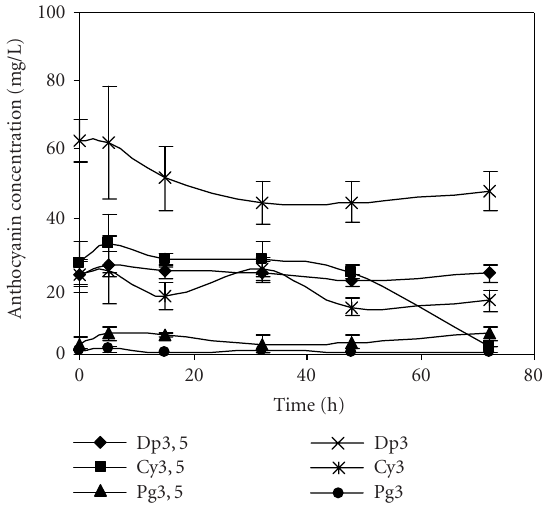
Figure 1. Evolution of concentration of anthocyanins present in the pomegranate juice obtained by seed centrifugation and stored for 72 hours at 4 ◦ C. Bars represent standard deviation of 4